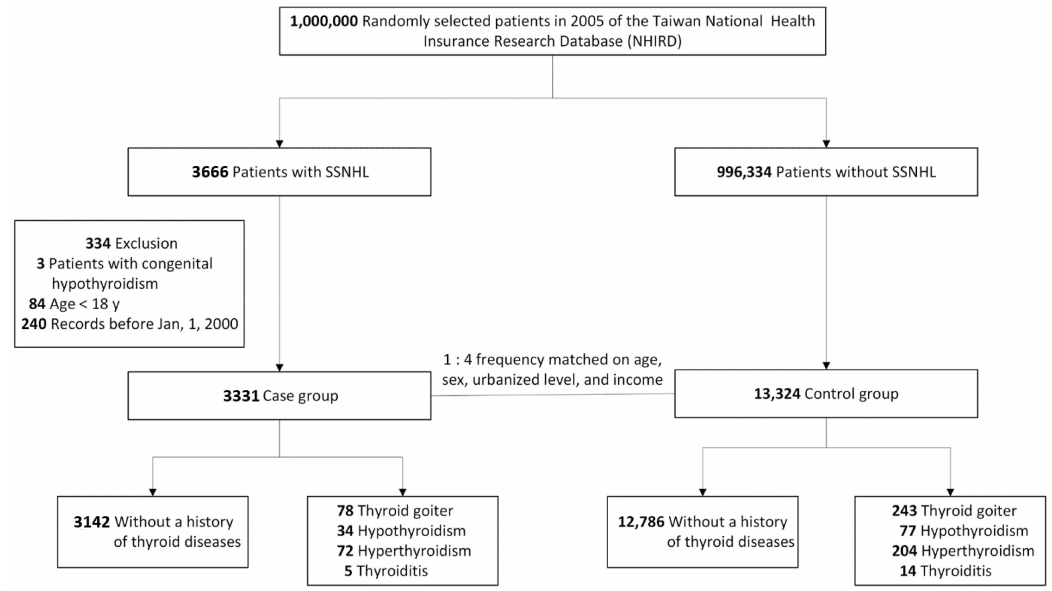
Figure 1. Flow diagram of participants selection and study design. SSNHL—sudden sensorineural hearing